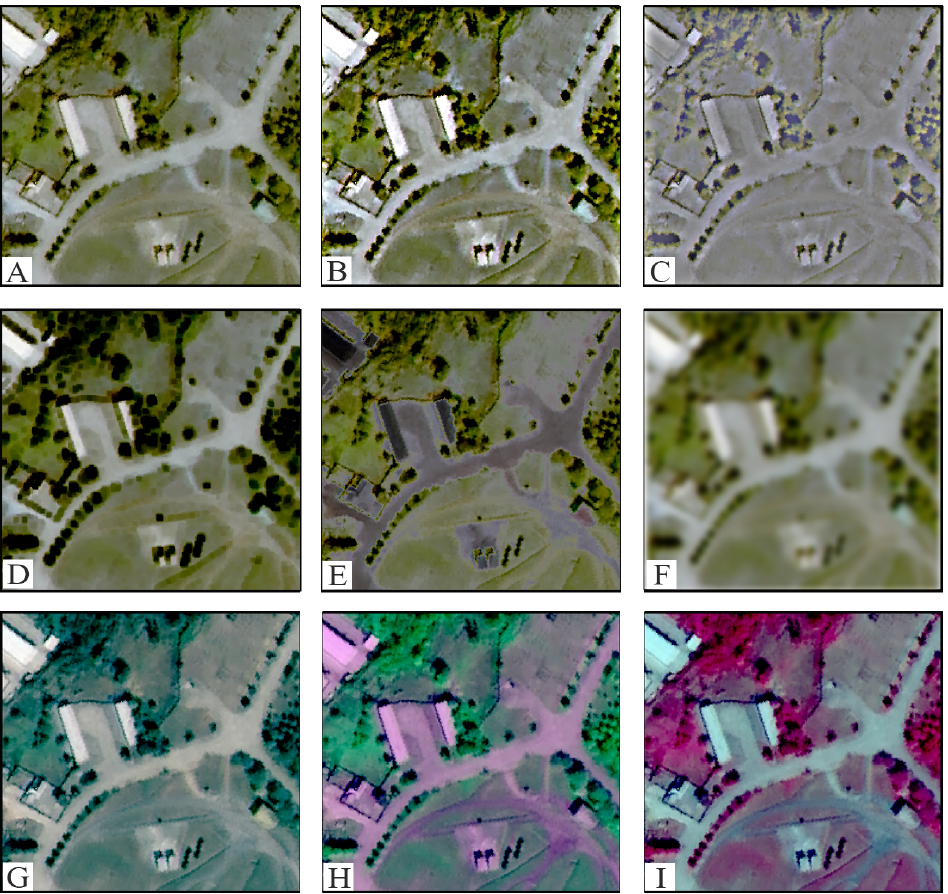
Figure 6. Sample expanded images: ( A ) original picture (band 1, band 2, band 3 combination); ( B ) high contrast retention; ( C ) maximum value; ( D ) minimum value; ( E ) overexposure; ( F ) Gaussian noise; ( G ) band 3, band 2, band 1 combination; ( H ) band 3, band 4, band 2 combination; ( I ) band 4, band 3, band 2 combination.